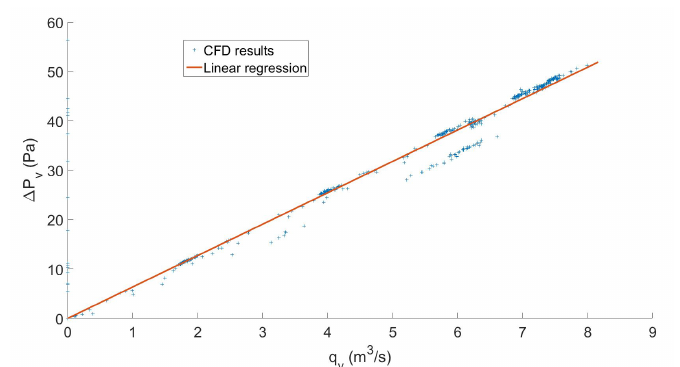
Figure 9. Flow rate across the HP valves as a function of the pressure drop with linear regression ( R 2 =